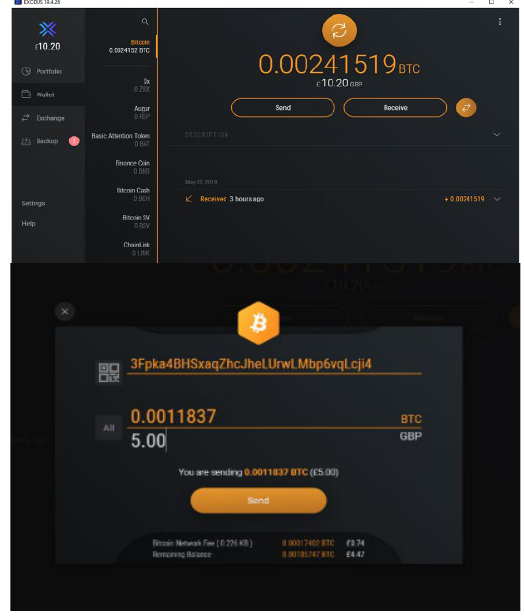
Figure 1. Exodus (Bitcoin wallet